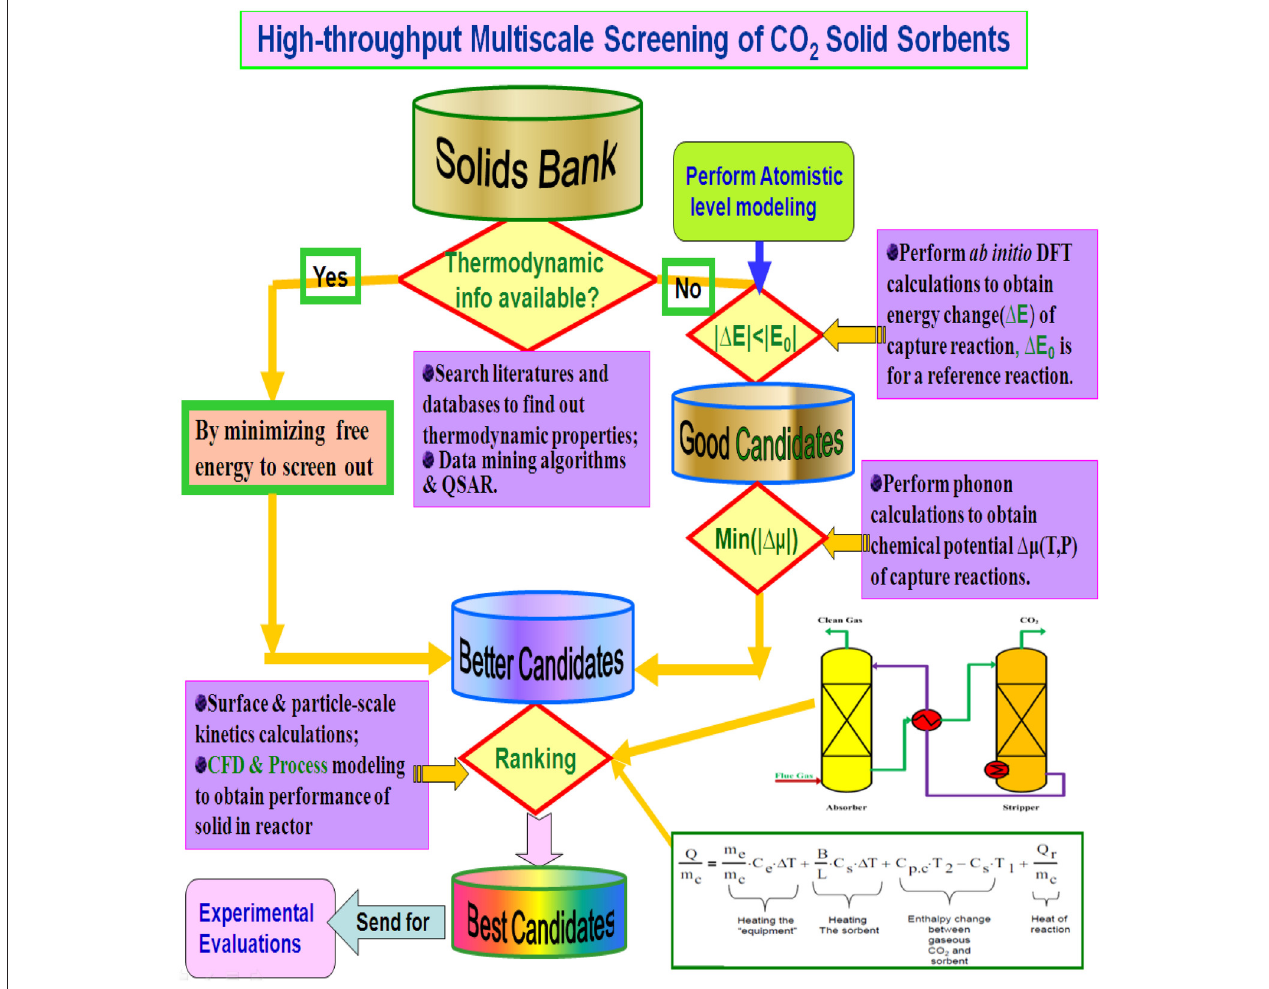
FIGURE 1 | Schematic of our screening